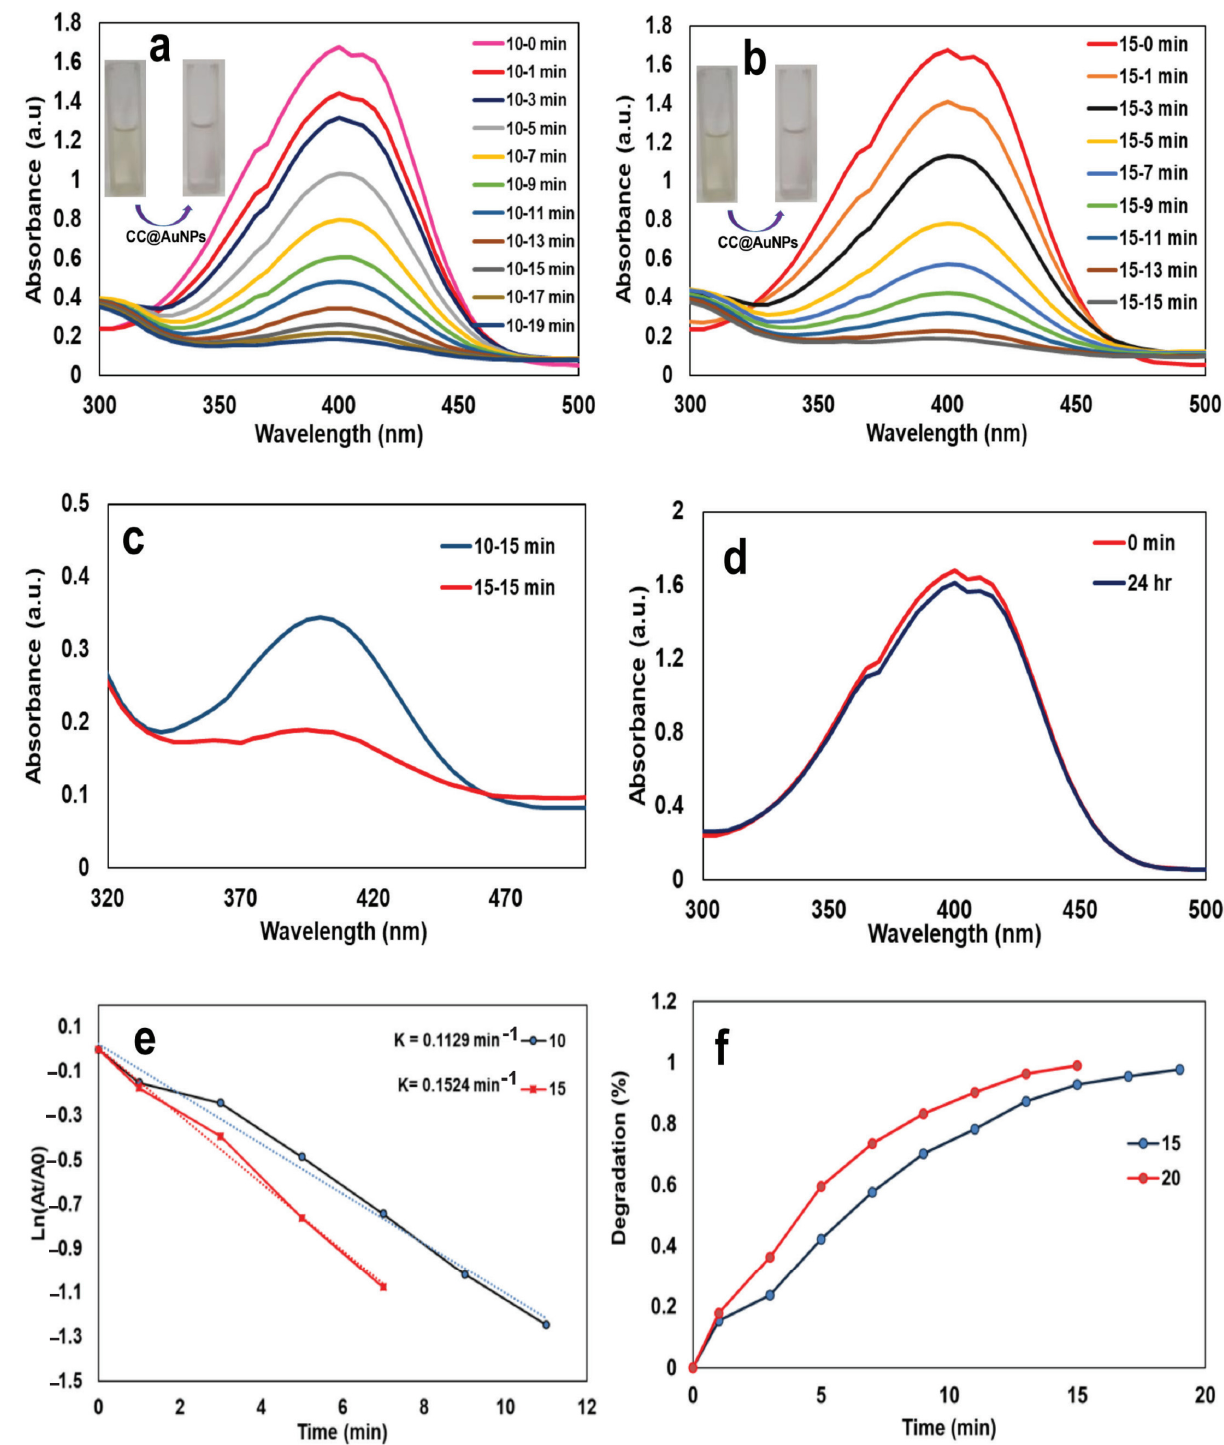
Figure 11. UV–Vis absorption spectra for the MB reduction with NaBH 4 catalyzed by ( a ) 150 µL, ( b ) 170 µL, and ( c ) 200 µL of CC-AuNPs (425 µg/mL), ( d ) the comparison of different volumes of CC- AuNPs. ( e ) UV–Vis spectra for the MB reduction with NaBH 4 only, without nanocatalyst, ( f ) the corresponding plots of ln(At/A0) vs time, ( g ) degradation percentage of MB.